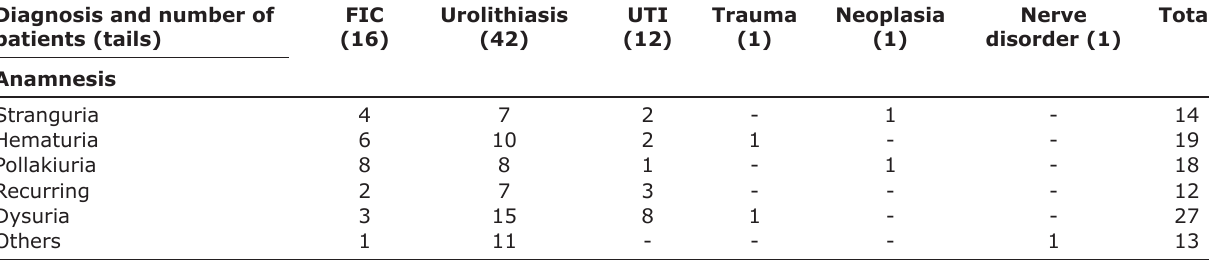
Table-2: The original anamnesis by the owner of the cat sample (in tails). Diagnosis and number of patients (tails)